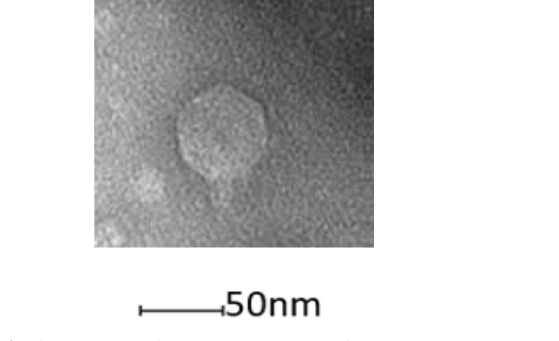
Figure 1. Morphology of phage NV1 by transmission electron microscopy. This phage has podovirus morphology .